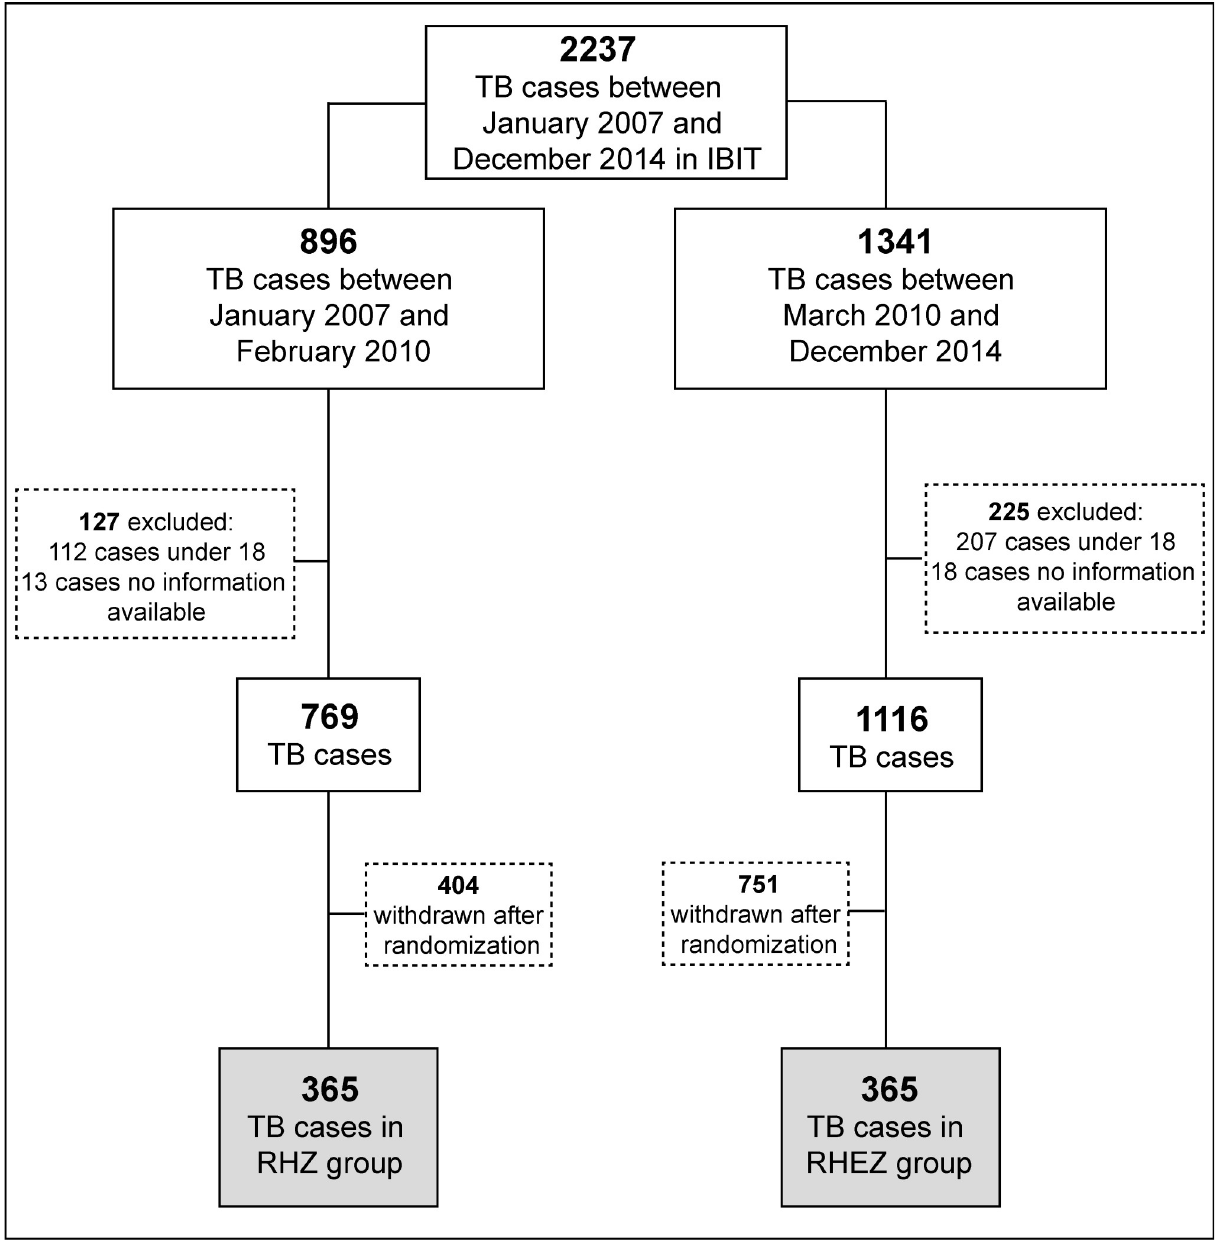
Fig 1. Study flow diagram. IBIT: Brazilian Institute for Tuberculosis Investigation (Reference Health Center); RHZ: Rifampicin (600mg), Isoniazid (400mg) and Pyrazinamide (2000mg). Dose to patients > 45kg; RHEZ: Rifampicin (150mg), Isoniazid (75mg), Ethambutol (275mg) and Pyrazinamide (400mg) (fixed dose